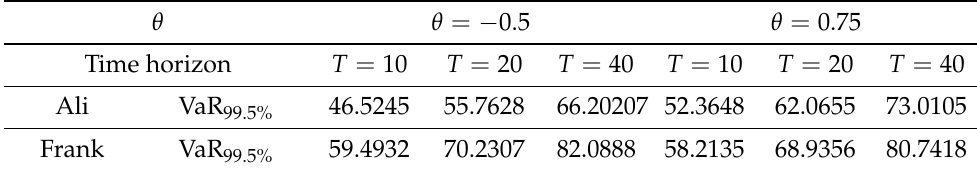
Table 5. Asymptotic value-at-risk for mixed homogeneous Poisson risk model with interest rate. θ θ = − 0.5 θ = 0.75 Time horizon T = 10 T = 20